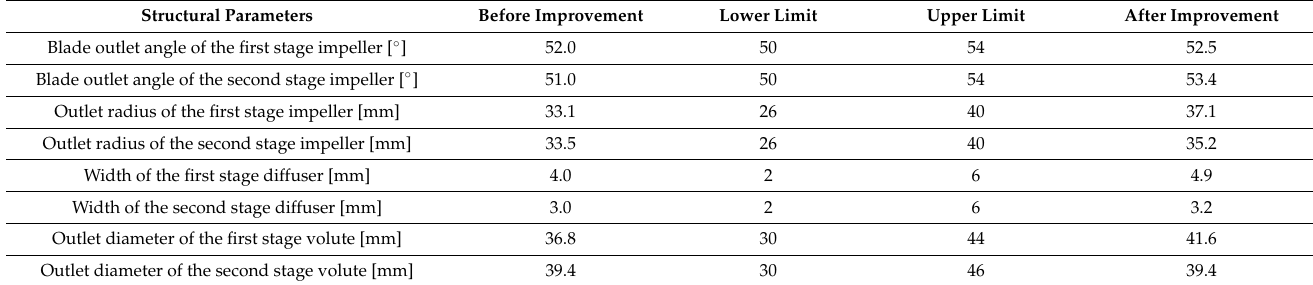
Table 6. Ranges and changes in structural parameters before and after improvement.